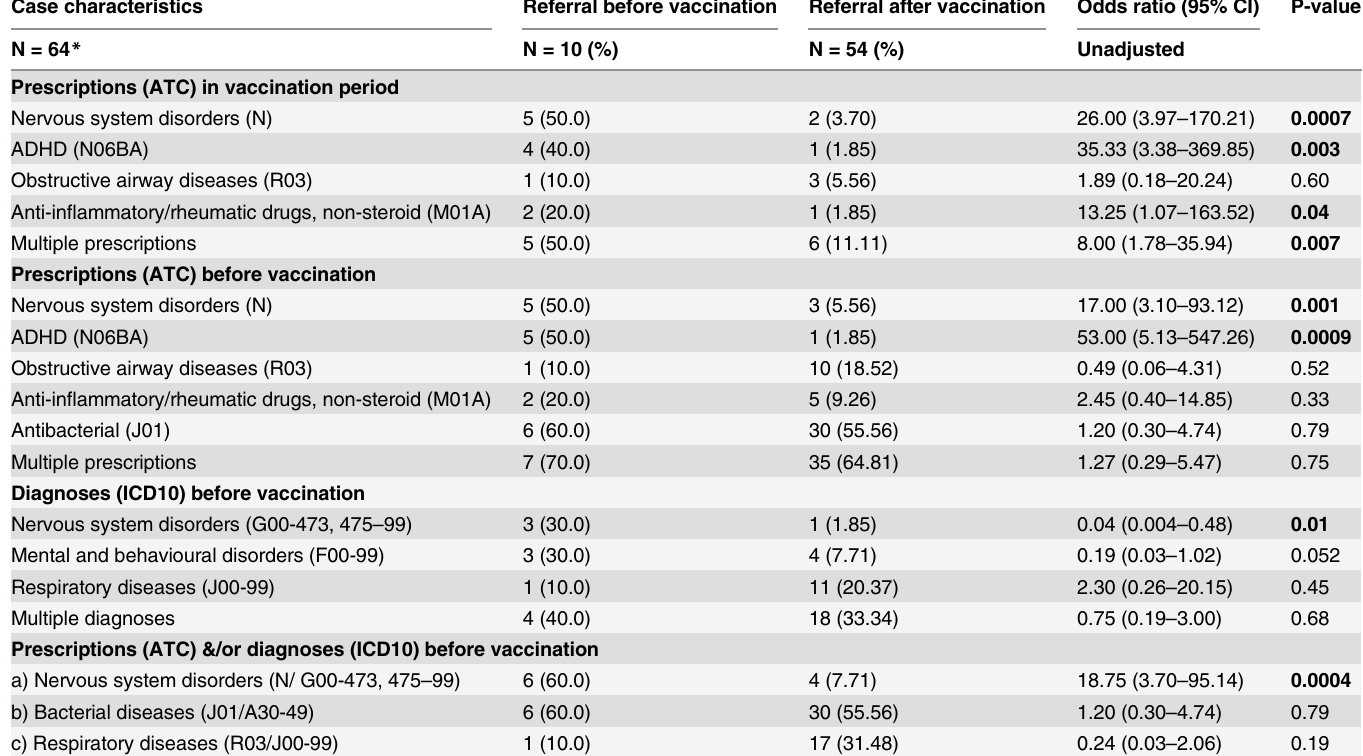
Table 4. Case-only analysis investigating prescription (ATC) history during the vaccination period and before index date and diagnosis (ICD10) history before index date on risk of developing